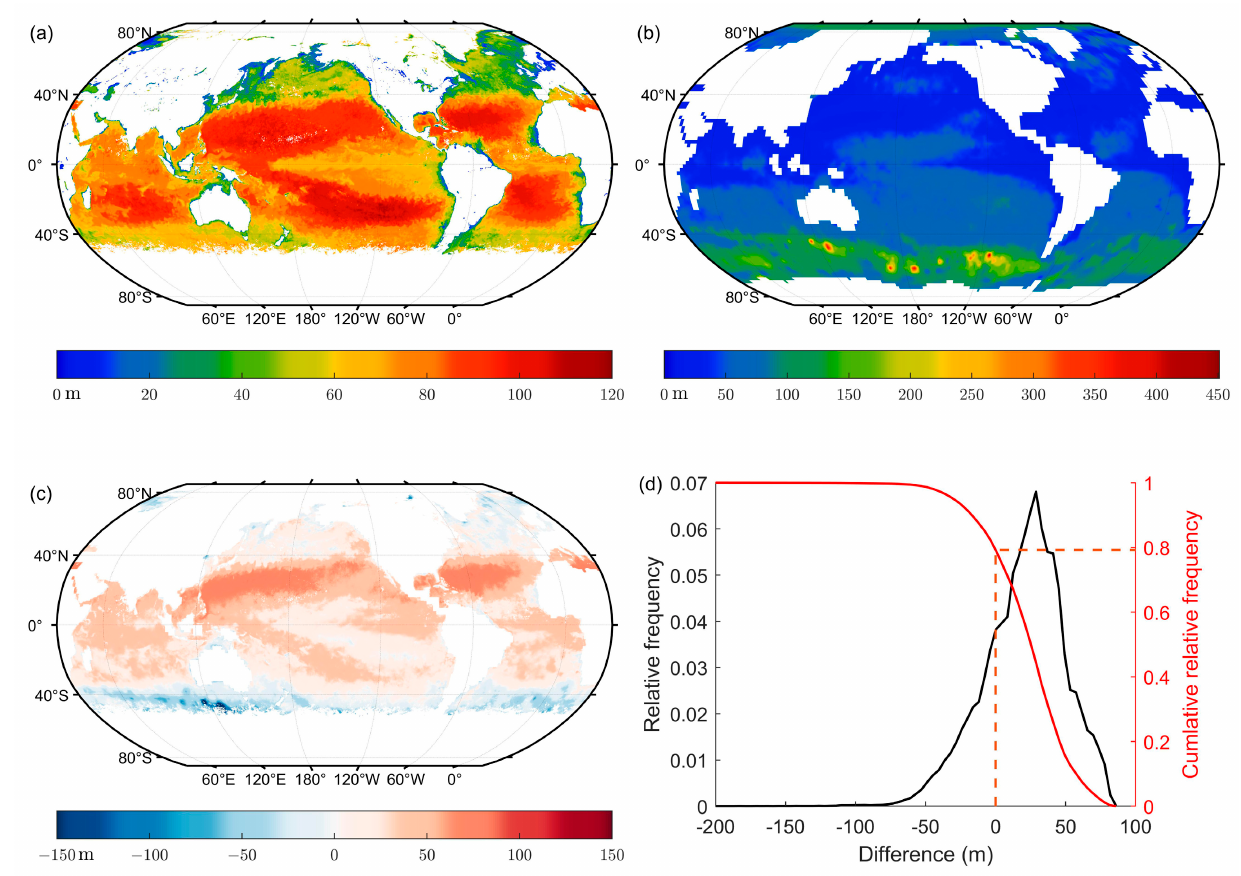
Figure 21. Comparison between lidar maximum detectable depth and MLD in the spring (the northern hemisphere). Distribution of the lidar maximum detectable depth at daytime ( a ), mixed layer depth ( b ), the difference between lidar maximum detectable depth and mixed layer depth ( c ), and the relative frequency distribution of the difference ( d ).